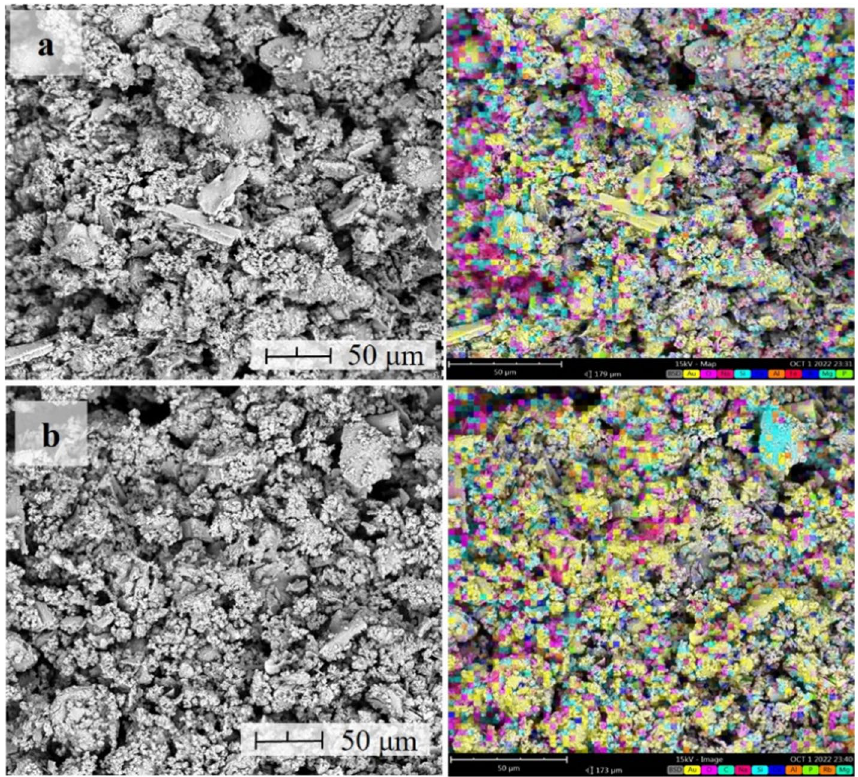
Figure 9. Morphological characteristics and elemental analysis of ( a ) GP-3 and ( b ) GP-4 samples.